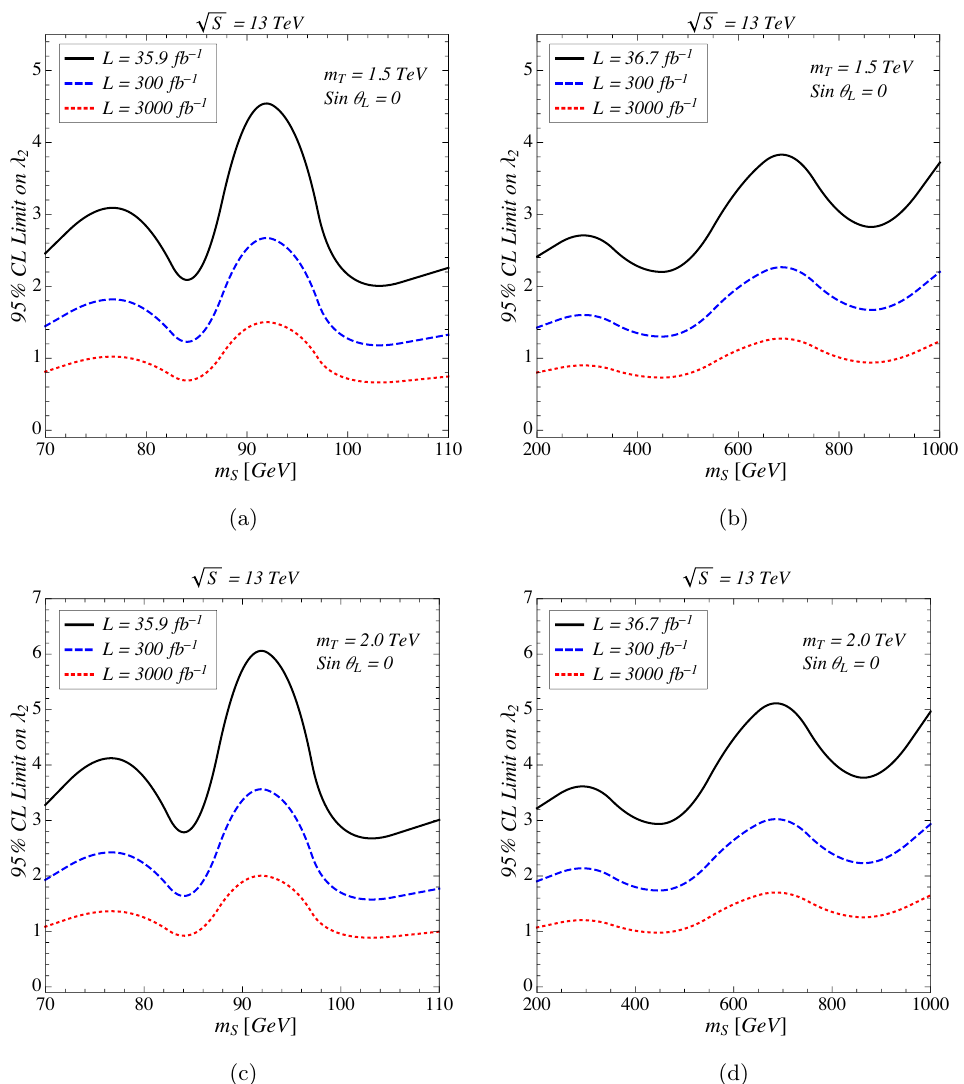
Figure 14 . The excluded regions of the parameter space in the (a,c) lower and (b,d) higher mass regions of S for (a,b) m T = 1 : 5 TeV and (c,d) m T = 2 : 0 TeV. The regions above the black solid line are excluded diphoton searches [131, 132] at the 13 TeV LHC. The blue dashed and red dotted curves are the projected exclusions with 300 fb (cid:0) 1 and 3000 fb (cid:0) 1 luminosities, respectively, via a naive rescaling based on the current